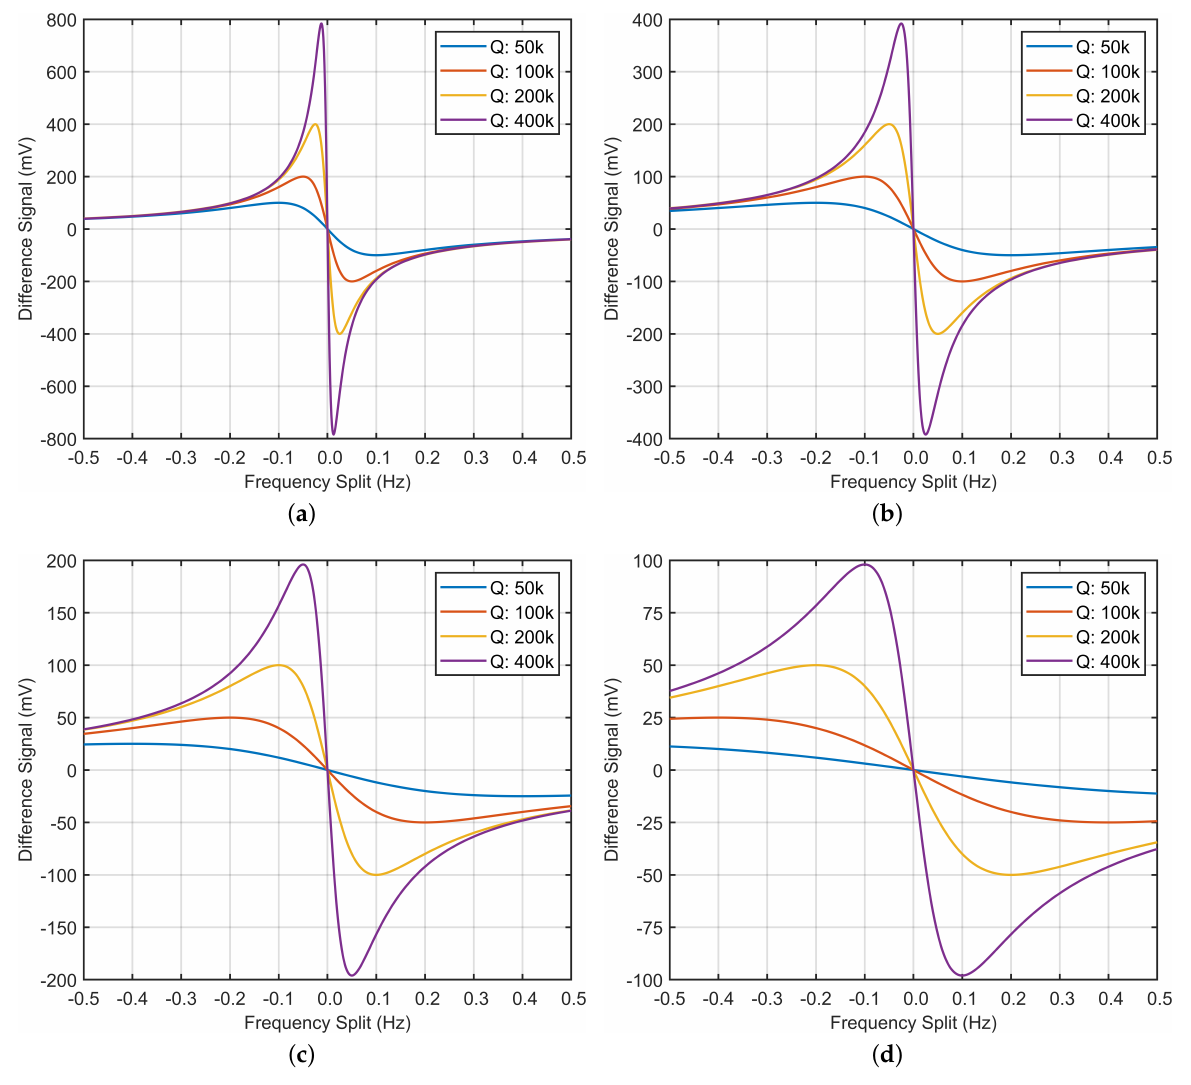
Figure 2. The relationship between the frequency split ∆ ω and the real part of difference signal Z diff . ( a ) Resonant Frequency 5 kHz. ( b ) Resonant Frequency 10 kHz. ( c ) Resonant Frequency 20 kHz. ( d ) Resonant Frequency 40